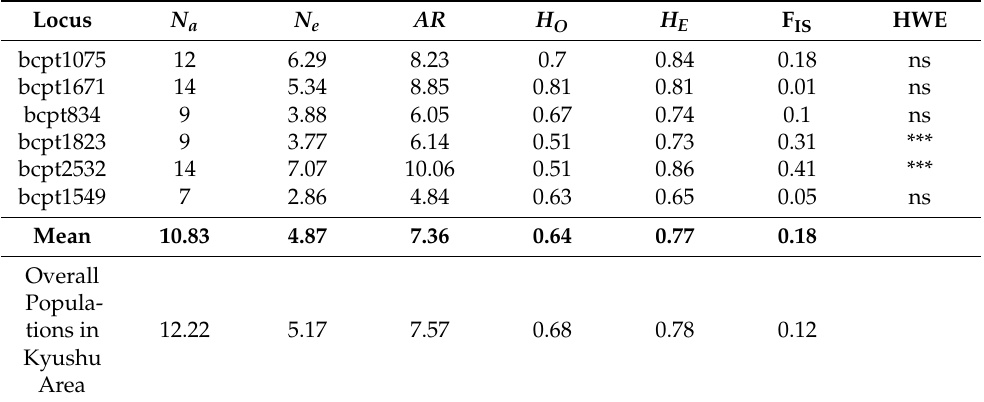
Table 4. Genetic diversity of the Kyushu PWN- P. thunbergii resistant trees using six primer markers compared with the overall genetic diversity of populations in the Kyushu area. Locus N a N e AR H O H E F IS